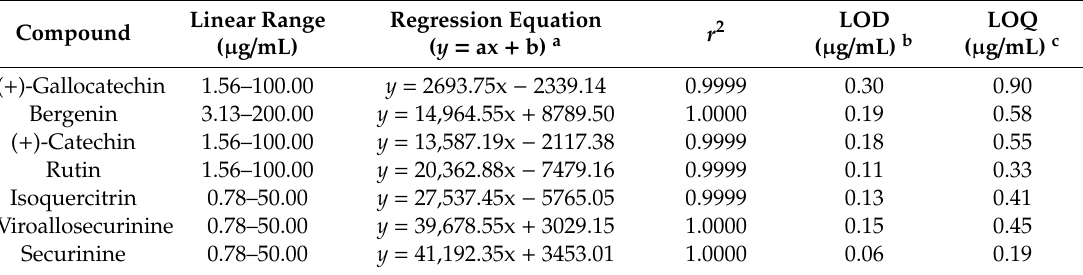
Figure 2. HPLC (High performance liquid chromatography) chromatograms of the standard solution ( A ), leaves ( B ) and twigs ( C ) of Securinega su ff ruticosa . ( + )-Gallocatechin (1), bergenin (2), ( + )-catechin (3), rutin (4), isoquercitrin (5), viroallosecurinine (6) and securinine (7). Table 1. Linear range, regression equation, r 2 , LOD (Limit of detection) and LOQ (Limit of quantitation) for marker compounds ( n =